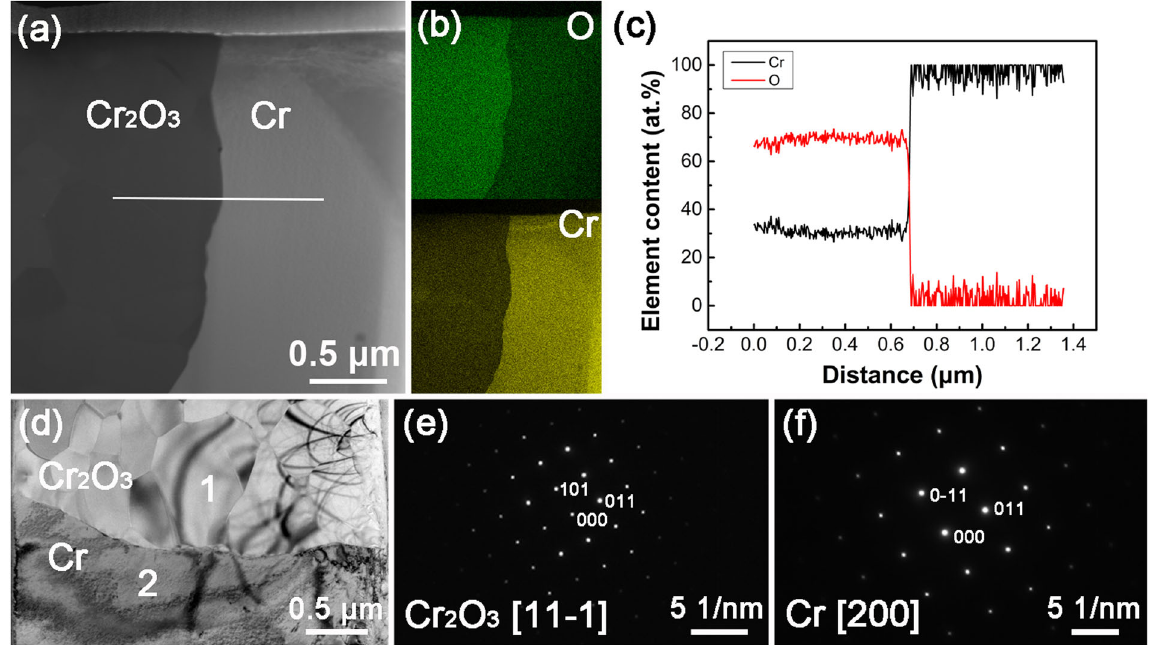
Fig. 6 Microstructures and compositions at the interface of layers 5/6 in Fig. 4. a HAADF and d TEM images of the Cr 2 O 3 and Cr, and corresponding b EDS mappings and c EDS line scan, SEAD patterns of the e Cr 2 O 3 and f